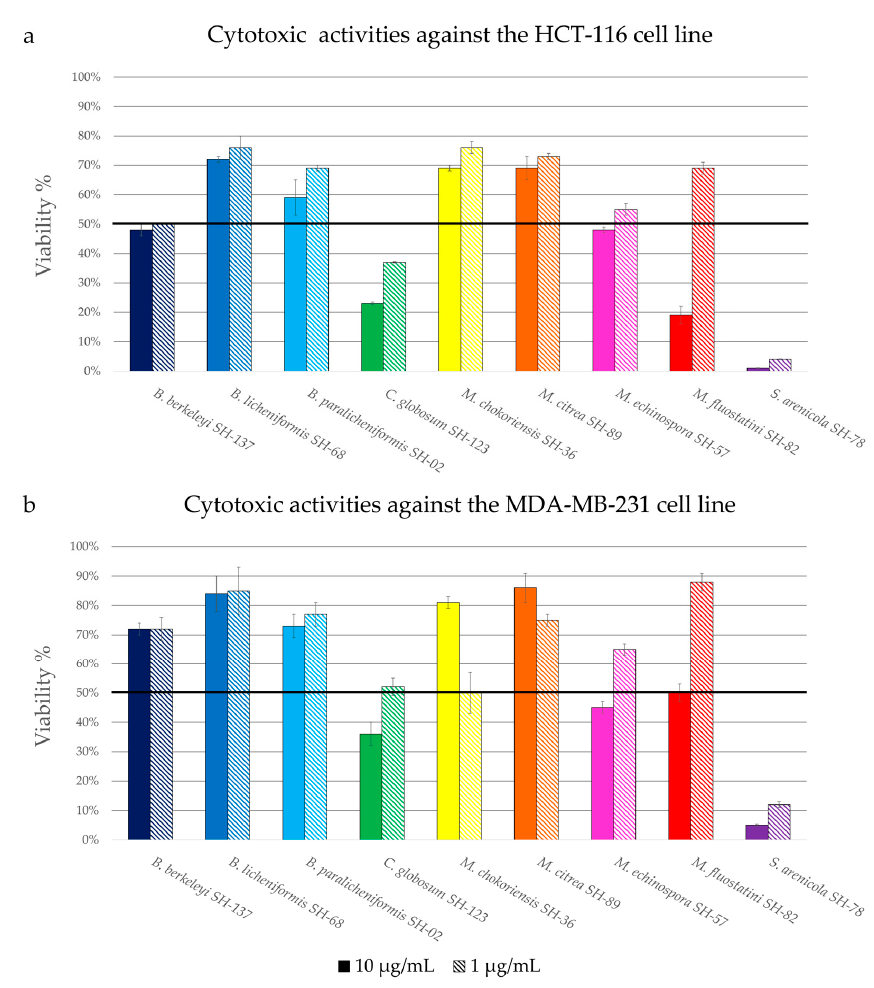
Figure 5. Cytotoxicity of the crude microbial extracts against the HCT-116 ( a ) and the MDA-MB-231 ( b ) cell lines, showing the ratio of viability. The different colors correspond to the different microbial strains. Horizontal black line indicates the threshold for promising strains (viability < 50%).